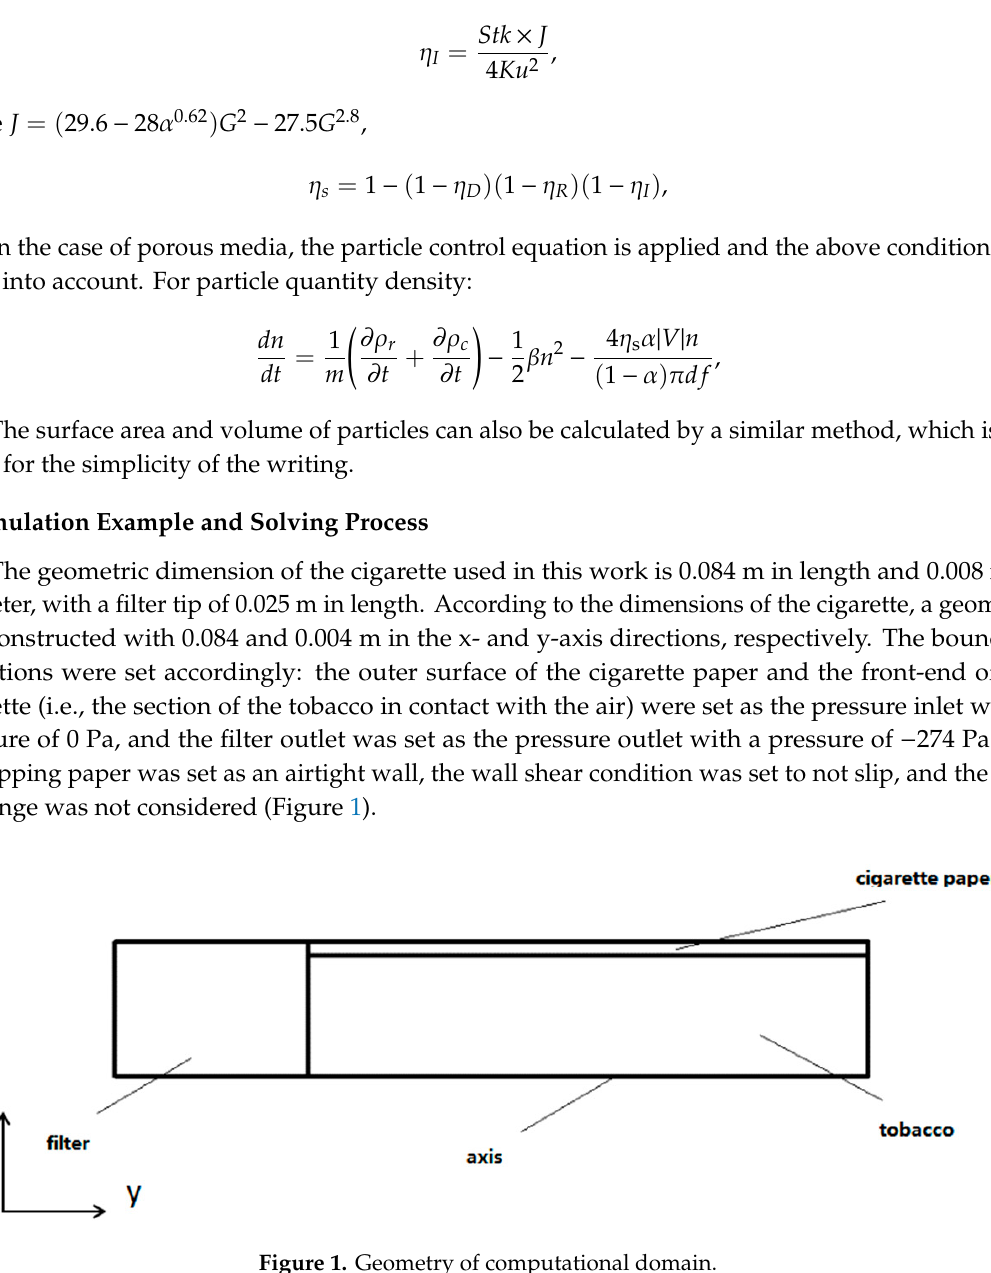
Figure 1. Geometry of computational domain.